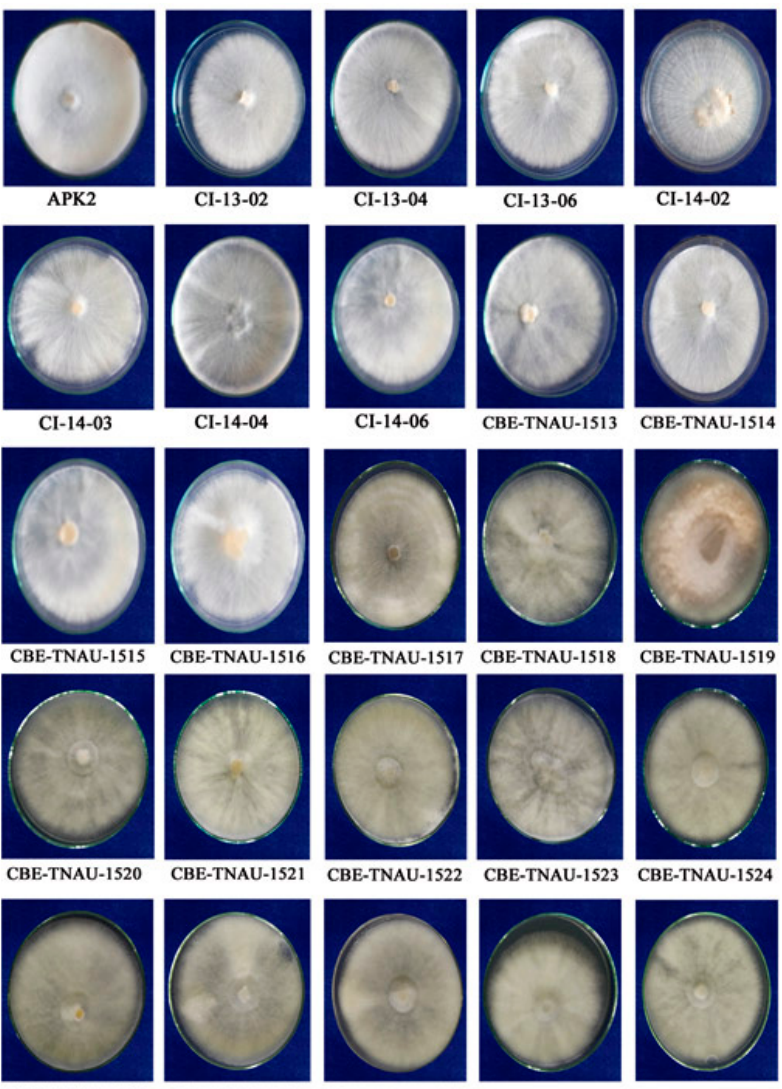
Fig. 1 . Cultural characters of milky mushroom isolates on PDA medium. White thick cottony growth with more or less smooth margin was observed in APK2, CI-13-02, C1-13-04, CI-14-06, CBE-TNAU-1514, 1515 and 1517. Thick cottony slightly yellowish colony growth was prominent in cases of CBE-TNAU-1522 and 1524. Silk thread like meandering mycelium was observed with respect to CI-14-04, CBE-TNAU-1519, 1521 and 1523. The isolates viz., CBE- TNAU-1523, CBE-TNAU-1603 and APK2 isolates were covering the maximum radial growth of 90 mm in Petri dish within 7